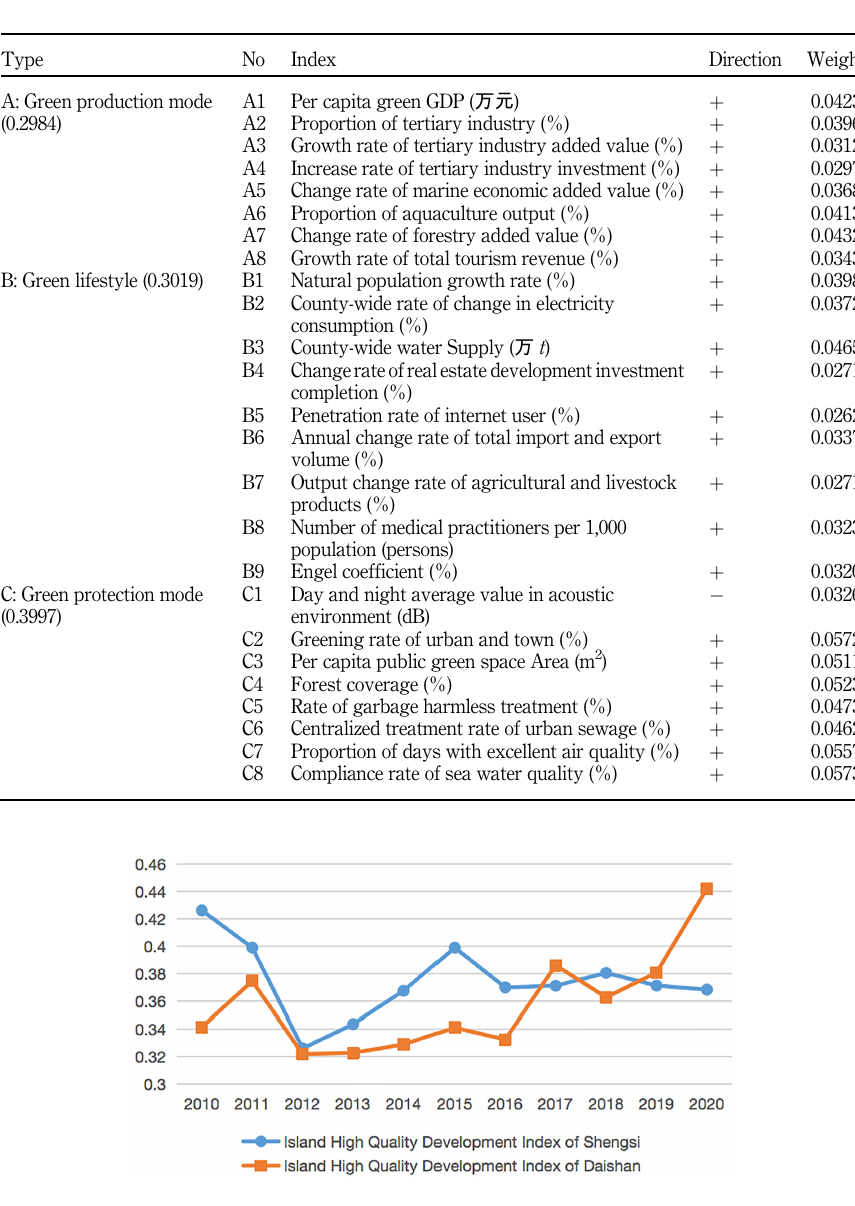
Figure 2. 2010 – 2020 Evaluation results of high-quality development index of